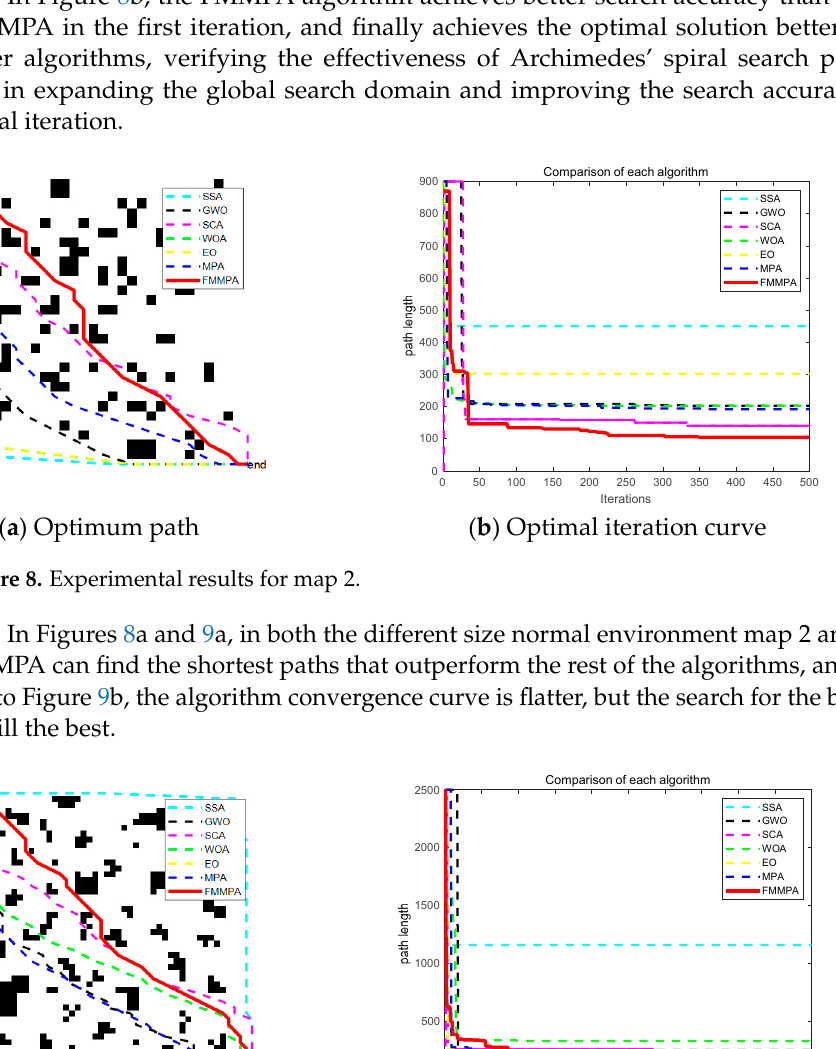
Figure 7. Experimental results for map 1.